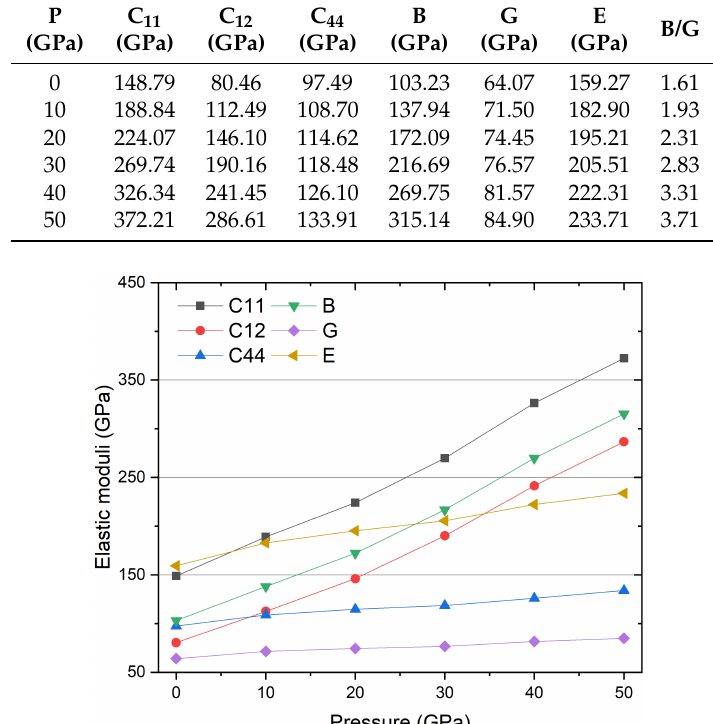
Table 1. The elastic constants C ij , bulk modulus B, shear modulus G, Young’s modulus E and Pugh’s ratio B/G of Ti 2 MnAl compound under different pressure.